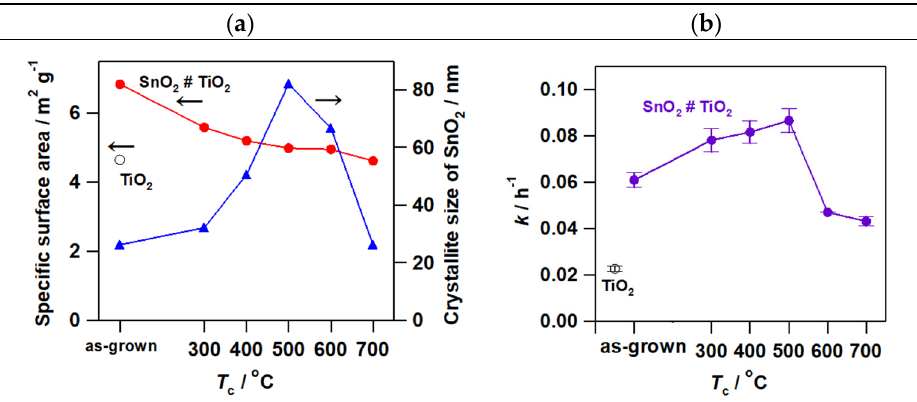
Figure 6. ( a ) Plots of specific surface area and SnO 2 crystallite size as a function of heating temperature ( T c ). ( b ) Relation between the photocatalytic activity and T c . The figure is taken from ref. [17].